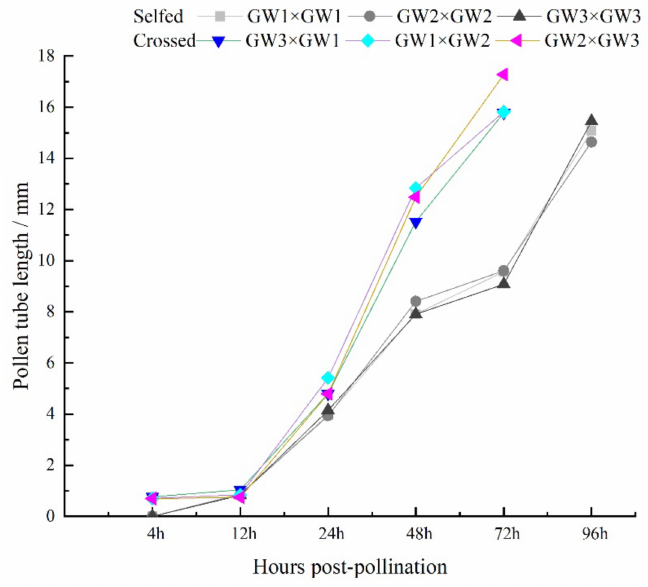
Figure 4. The growth of the selfed and crossed pollen